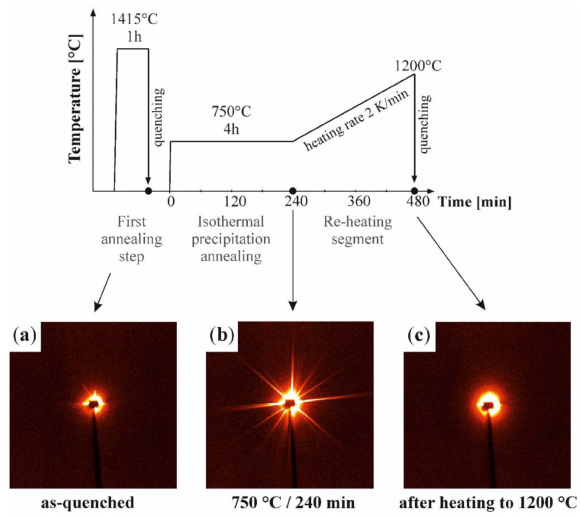
Figure 10. Time-temperature profile of the heat treatment conducted as described in [44]. Dots at certain stages of the profile correspond to the SAXS detector images displayed below ( a , b , c ). See the text for